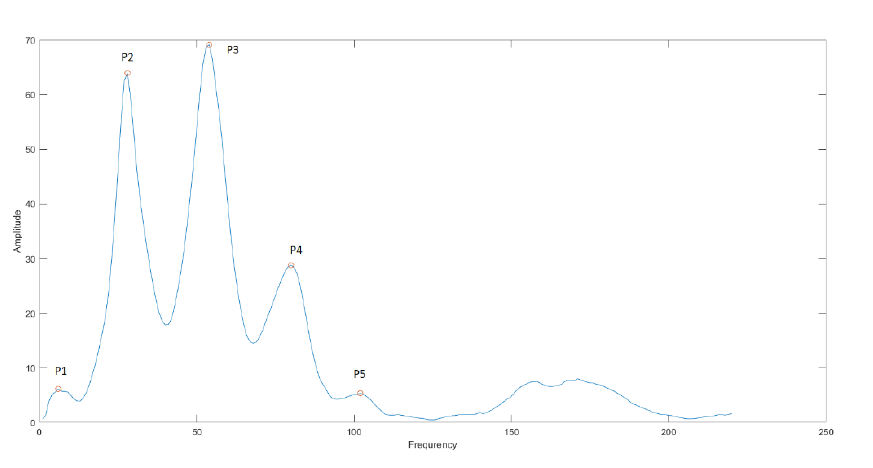
Figure 4. The algorithm operation for searching the peaks (first five) for one of the signals. To generate test data and develop an algorithm, five characteristic points were iden- tified for each obtained signal spectrum. These five points are the very first five peak points of the spectrum. A pre-analysis of the data showed a spread of the number of peaks for each signal, from 7 to 15. For the initial stage, the first five peaks were selected. The number five gives further insight into the effect of the number of peaks selected as an input on